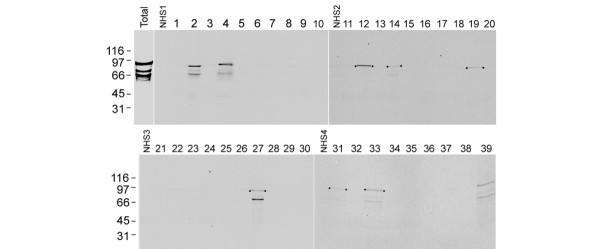
Immunoprecipitation analysis of the 39 BD patients for autoantibody to kinectin. In vitro translation products of kinectin cDNA BD44 template was used as the substrate. Nine out of the 39 BD patient sera (23%, lanes 1–39) immunoprecipitated the BD44 translation products. Molecular weight standards are shown on the left. The lane marked 'Total' shows the labeled translation product alone for comparison. Lanes NHS1, NHS2, NHS3, NHS4 are the four normal controls. BD, Behçet's disease.